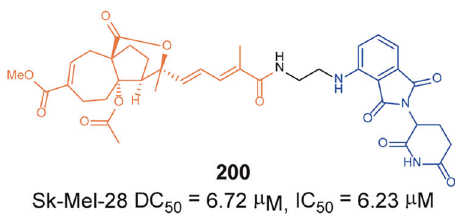
Fig. 55 The representative PROTAC targeting